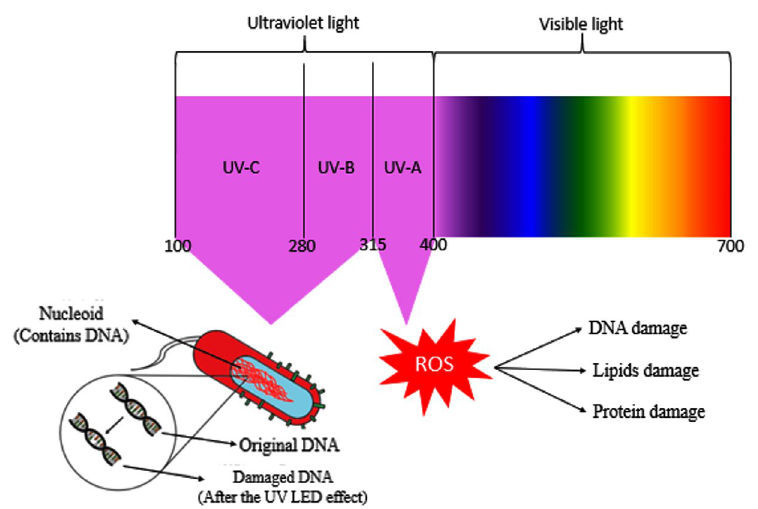
Fig. 2. Illustration of UV LED mechanism to bacterial